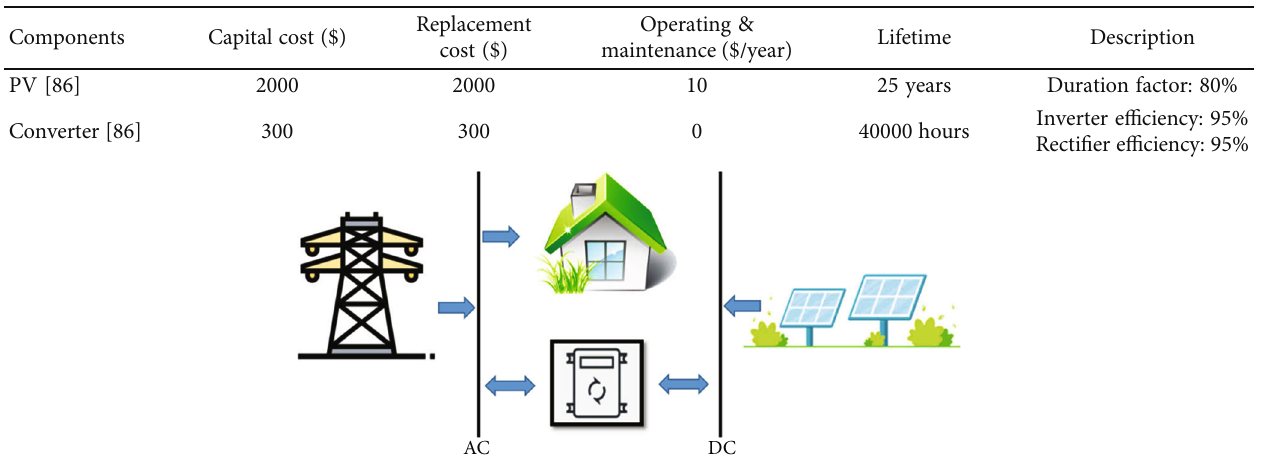
Table 4: The cost of the equipment used in the